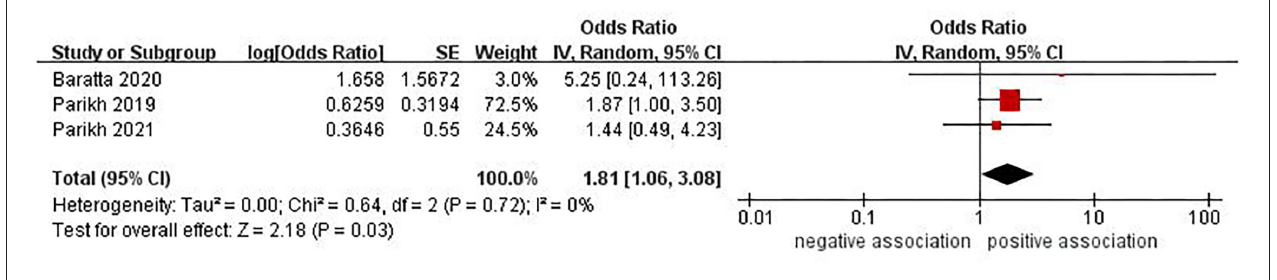
FIGURE 4 | Forest plot of evaluating the association between NAFLD-fibrosis (by FIB-4) and